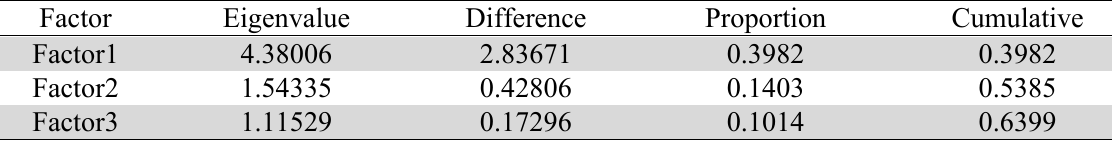
The analysis of sustainable development factors